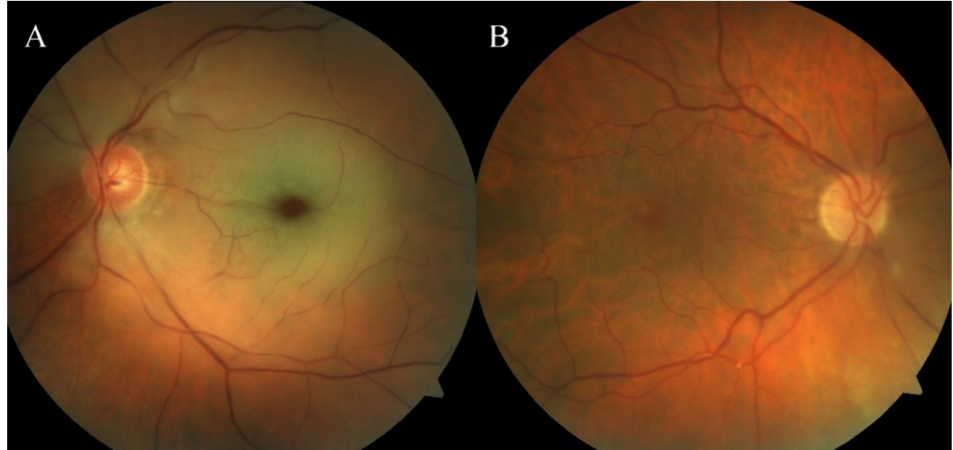
Figure 1. Fundus images of CRAO ( A ) and BRAO ( B ). Figure 1A shows CRAO in the left eye with diffuse retinal whitening due to ischemia and cherry-red spot. Figure 1B shows BRAO in the right eye with visible emboli in a retinal